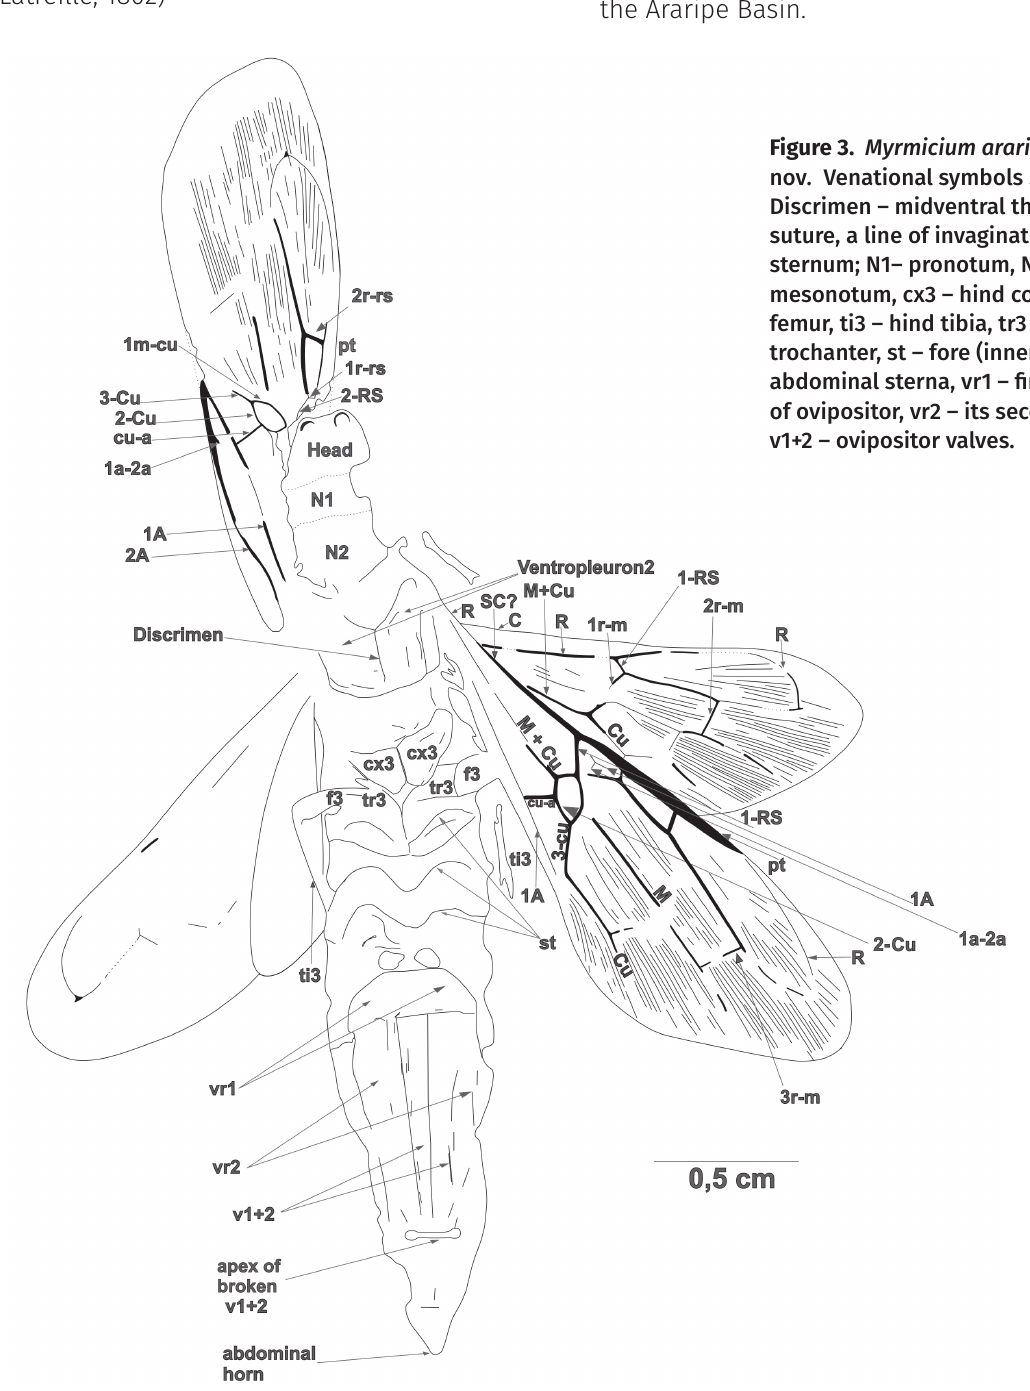
Figure 3. Myrmicium araripterum,